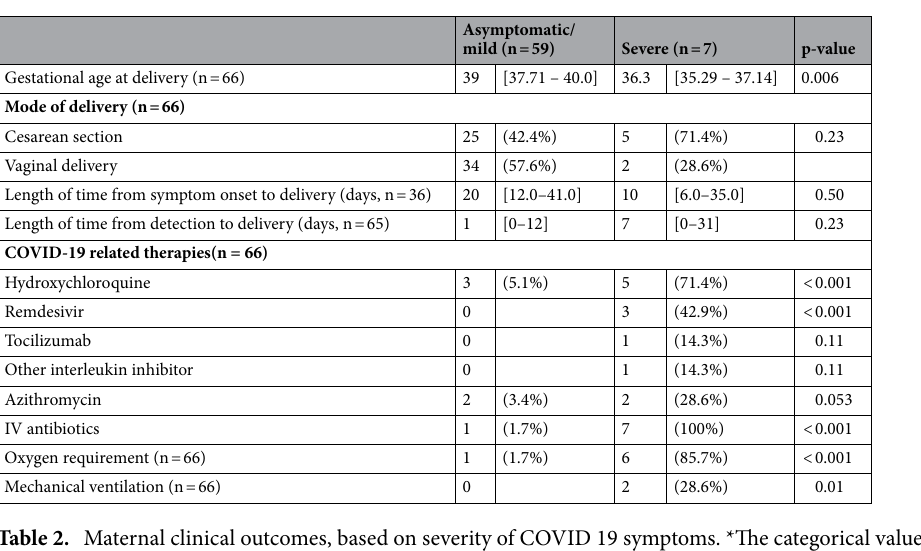
Table 2. Maternal clinical outcomes, based on severity of COVID 19 symptoms. *The categorical values are expressed as n (%), the continuous variables are expressed as either median [IQR] or mean ± SD.